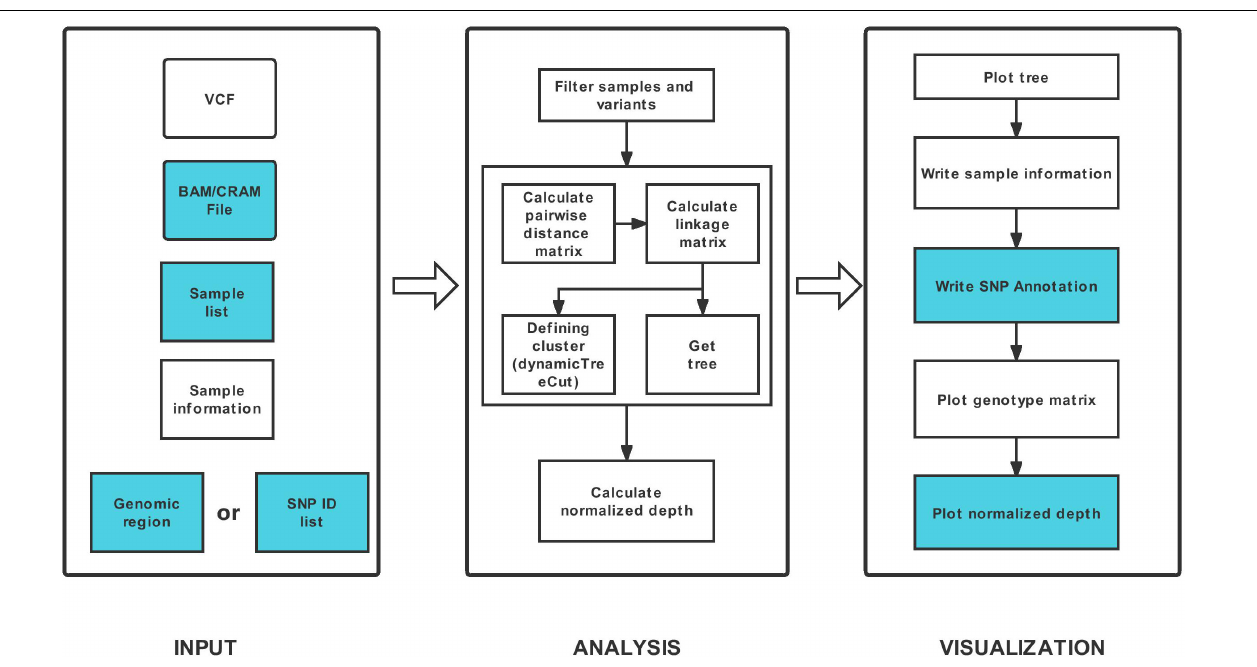
FIGURE 1 | Workflow of HAPPE. The inputs and outputs colored in white are required, whereas the others are